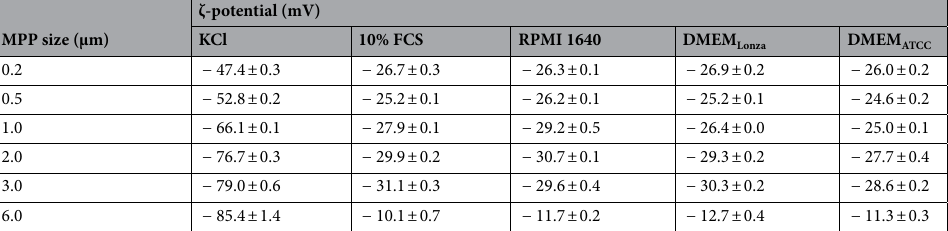
Table 1. ζ-potential analysis of differently sized PS-MPP. MPP were incubated in 1 mM KCl or pre-incubated overnight in growth media (DMEM or RPMI) or 10% (v/v) FCS in 1 × DPBS. The ζ-potential was measured in 1 mM KCl (pH 6). Data represent mean ± SD, n =